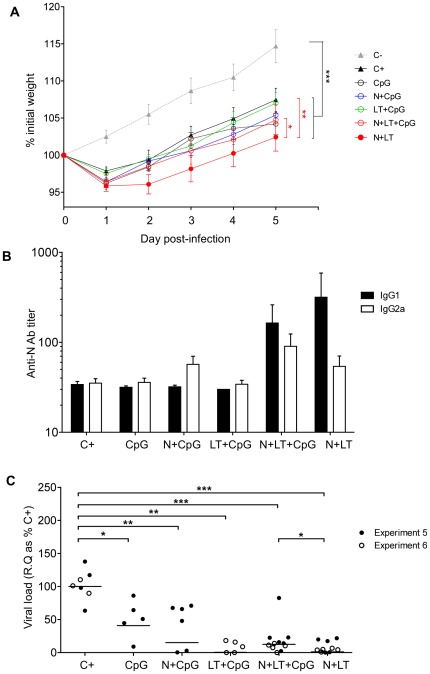
CpG added to the neonatal vaccine reduced weight loss, increased secondary IgG2a response and maintained viral protection upon RSV challenge.Mice vaccinated as neonates as indicated or non vaccinated littermates (C+) were sacrificed 5 days after the hRSV-A2 challenge. Data from 2 independent experiments combining different treatment groups are shown with ≥5 mice per group (C+: n = 7, CpG: n = 5, N+CpG: n = 6, LT+CpG: n = 5, N+LT: n = 10, N+LT+CpG: n = 11). (A) Mice were weighed daily from d0 till d5 p.i. and individual weight loss/gain was calculated as % of initial weight. Statistical analysis was performed to compare growth over the period d2 to d5 p.i. using the Tukey's multiple comparison test, repeated measures one way ANOVA (* p<0.05; ** p<0.01 and *** p<0.001). (B) IgG1 and IgG2a anti-N antibodies were titrated by ELISA in sera collected 5 days after the challenge. Data are mean±SEM from n≥5 mice per group. (C) Individual viral load in lungs: R.Q. of N transcripts, normalized to HPRT, are expressed as % of the mean of unvaccinated infected control group (C+) (R.Q. = 100×2−ΔΔCt). Data from 2 independent experiments combining different treatment groups are shown. Mann-Whitney U-test was used for comparison between treatments (* p<0.05; ** p<0.01; *** p<0.001 and **** p<0.0001).